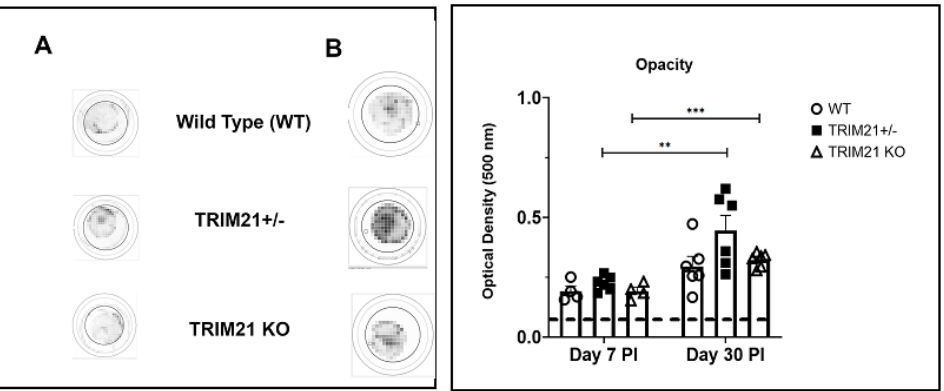
Figure 3. Corneal opacity is equivalent amongst WT, TRIM21+/ − , and TRIM21 KO mice at different times post HSV-1 infection. Male and female C57BL/6 (WT), TRIM21+/ − , and TRIM21 KO mice (n = 4–6/group) were infected with HSV-1 (10 3 PFU/cornea). At day 7 ( A ) or day 30 ( B ) post infection (PI), the mice were exsanguinated and the corneas were removed and assessed for opacity by optical density, using a plate reader, with tissue analyzed at 500-nm wavelength using a 30 × 30 matrix distributed over the cornea surface. Left panel is a representative cornea image from each mouse genotype captured at 500 nm. A summary of the results is shown in the right panel. Bars represent the mean + SEM. ** p < 0.01, *** p < 0.001 comparing the day 7 to day 30 pi timepoints, as determined by Kruskall–Wallis ANOVA and the Holm–Sidak post hoc t